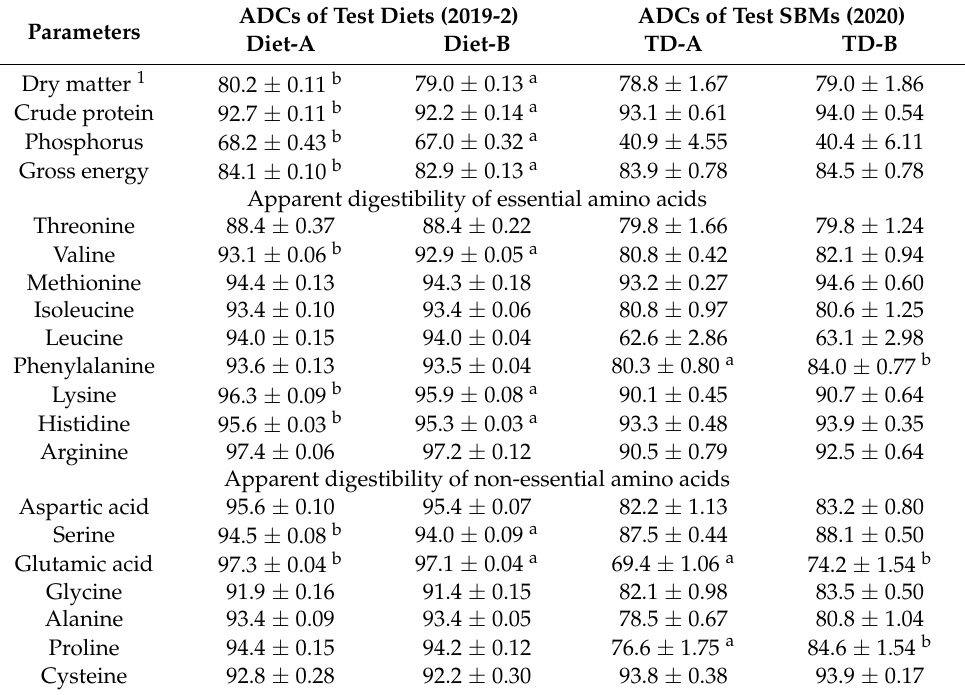
Table 10. Apparent digestibility of nutrients and energy in the tested diets and the tested soybean meals (SBMs) for Nile tilapia (means ± SEM. n =